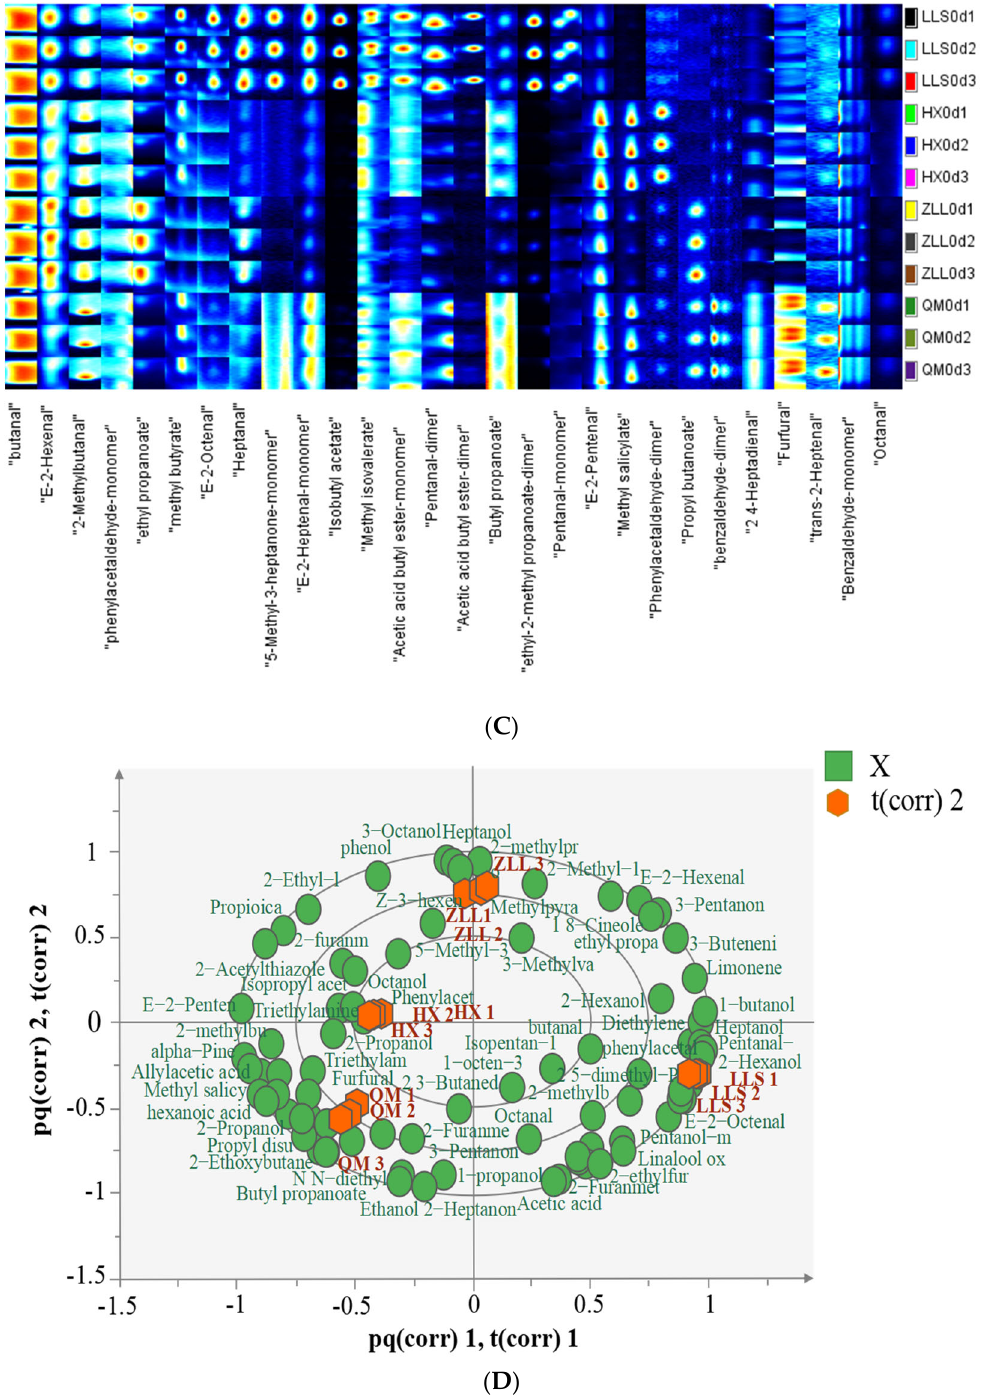
Figure 4. Analysis of volatile compounds. ( A ) Fingerprint mapping of acids and alcohols, ( B ) fingerprint mapping of ketones and others, ( C ) fingerprint mapping of aldehydes and esters, ( D ) PCA.